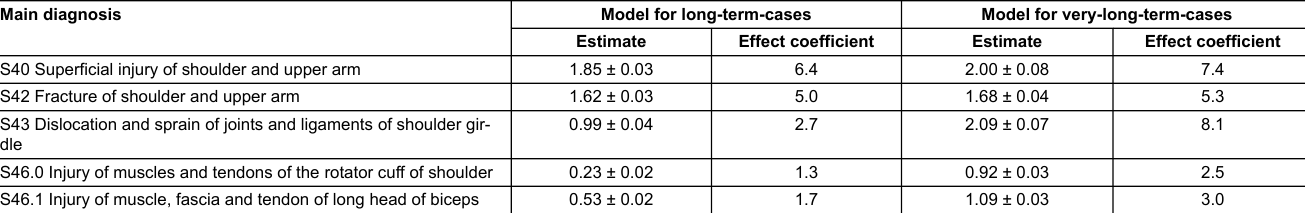
Table S2: Logistic regression estimates (± standard error) showing the effect of frozen shoulder on the probability to be a long-term or very-long-term case, standardised for 40-year-old